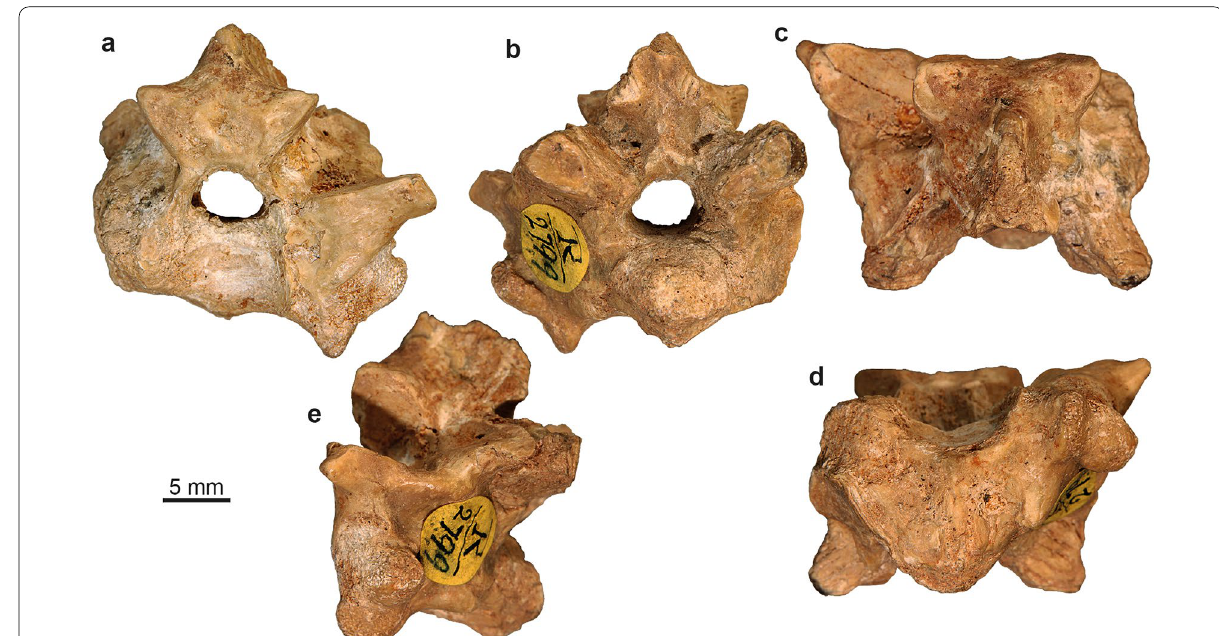
Fig. 15 Palaeopython cadurcensis from an imprecisely known locality in the Phosphorites du Quercy: probable cloacal vertebra (NHMUK PV R 2799(1)) in anterior ( a ), posterior ( b ), dorsal ( c ), ventral ( d ), and left lateral ( e )